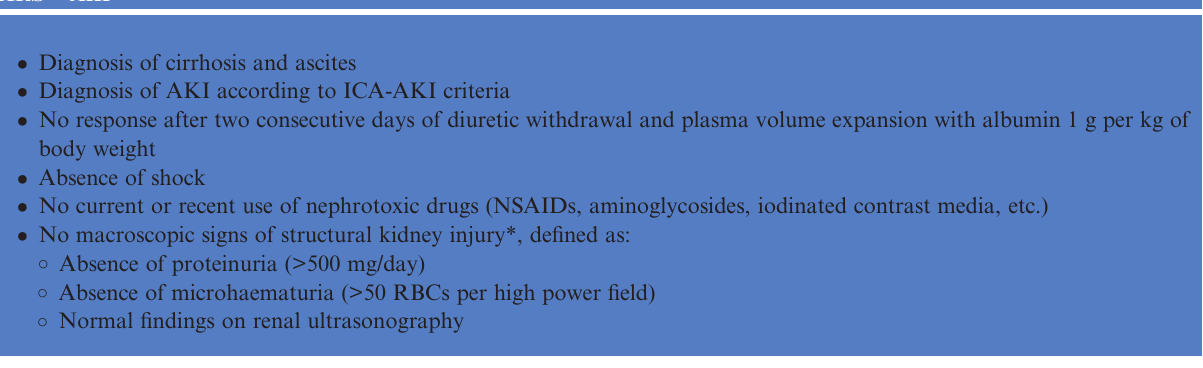
Table 2. Diagnostic criteria of HRS type of AKI in patients with cirrhosis HRS – AKI (cid:129) Diagnosis of cirrhosis and ascites (cid:129) Diagnosis of AKI according to ICA-AKI criteria